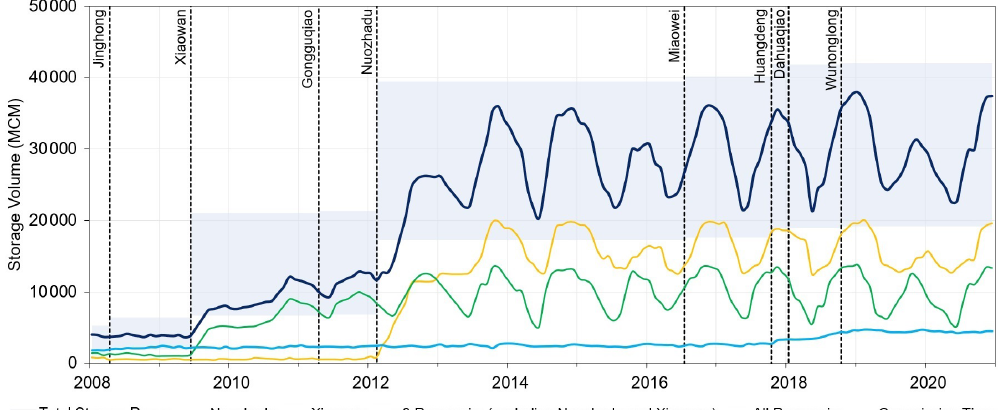
Figure 9. The blue shaded area represents the range of variability of the total system’s storage (between dead- and full-storage volume), while the actual storage dynamics are represented by the dark blue line. The storage dynamics of Nuozhadu, Xiaowan, and the remaining eight reservoirs are illustrated by the yellow, green, and blue lines. The vertical dashed lines denote the year of commission of each reservoir. Note that Manwan and Dachaoshan began operations in 1992 and 2003, respectively. We provide the storage time series of each individual reservoir in Fig.